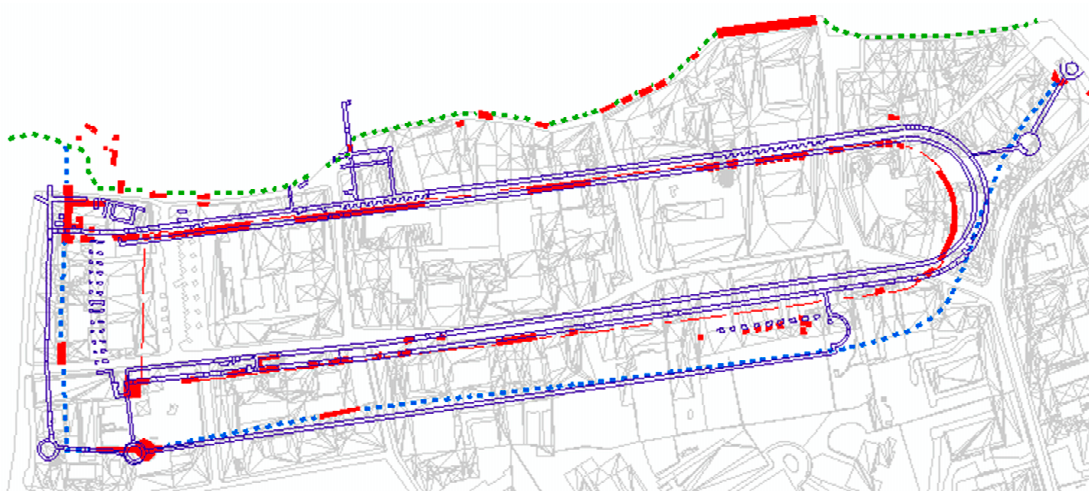
Figure 9. The overlapping of the two maps of the Roman Circus of Milan: De Capitani’s map in red, and Mirabella Roberti’s map in blue.